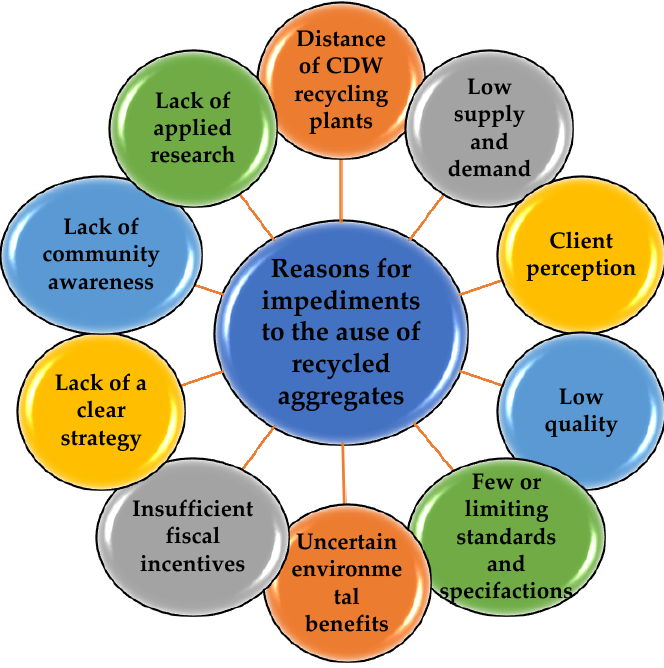
Figure 4. Reasons for impediments to the widespread use of recycled aggregates.